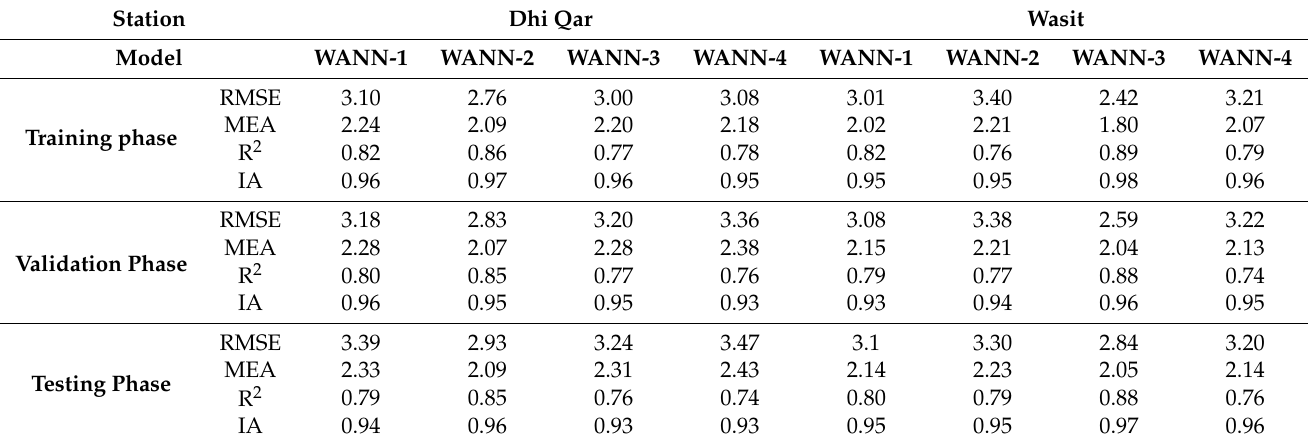
Table 2. The results of statistical analysis of different input patterns of WANN model in Rs evaluation.